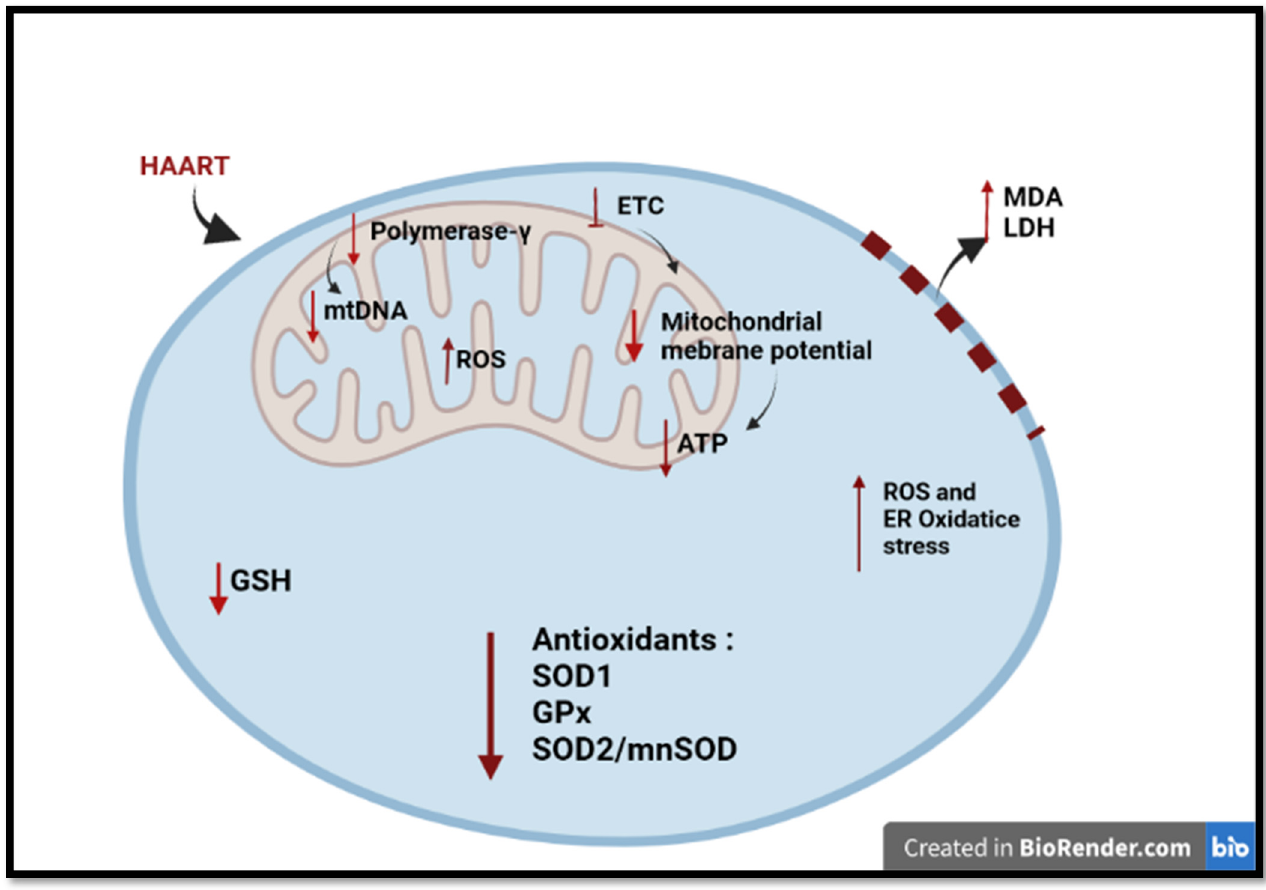
Figure 1. An overview of long-term HAART mitochondrial toxicity and oxidative stress in HIV- positive individuals. HAART interferes with the synthesis of polymerase- γ , reducing the mtDNA. This therapy impairs ETC, increasing ROS production, depolarizing the mitochondrial membrane, and compromising the ATP synthesis. HAART also depletes GSH and other cellular antioxidants, propagating oxidative stress in the cell. Created with BioRender.com (access date: 2 June 2022). The NRTIs impairs oxidative phosphorylation (OXPHOS) proteins and increases ox-